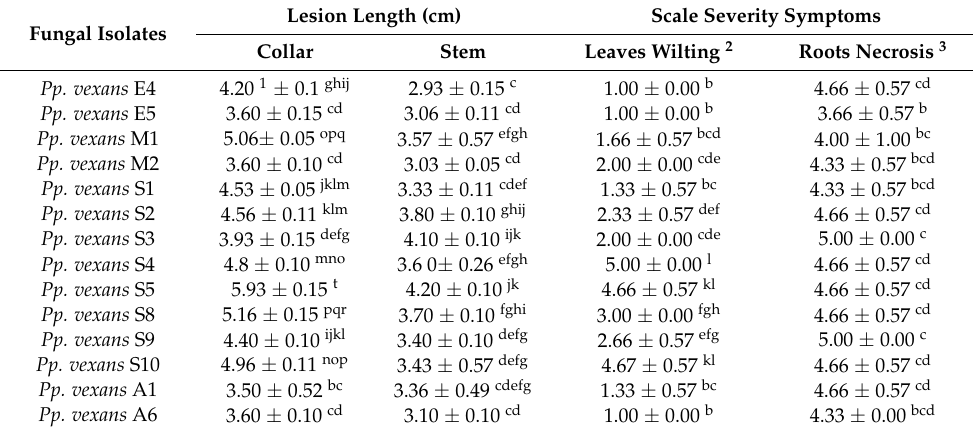
Table 3. Results of pathogenicity tests in apple seedlings showing the averaged collar and stem lesion length (cm), leaves, and root necrosis indices (1–5) after 4 months post-inoculation. Fungal